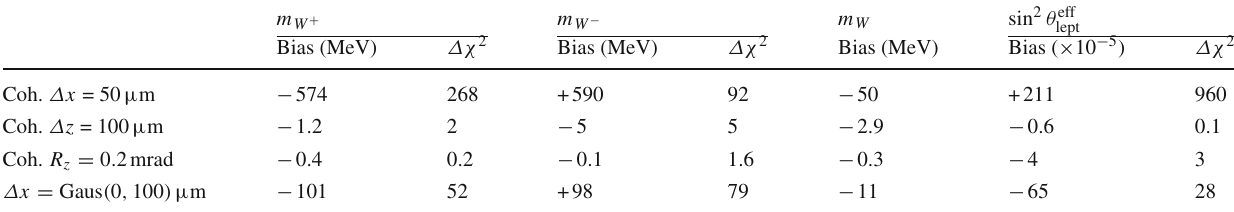
, and the first four is-alignment scenarios in an example toy measurement. The lept overall bias in m W , given by the weighted average of the biases for m W + and m W − , is also